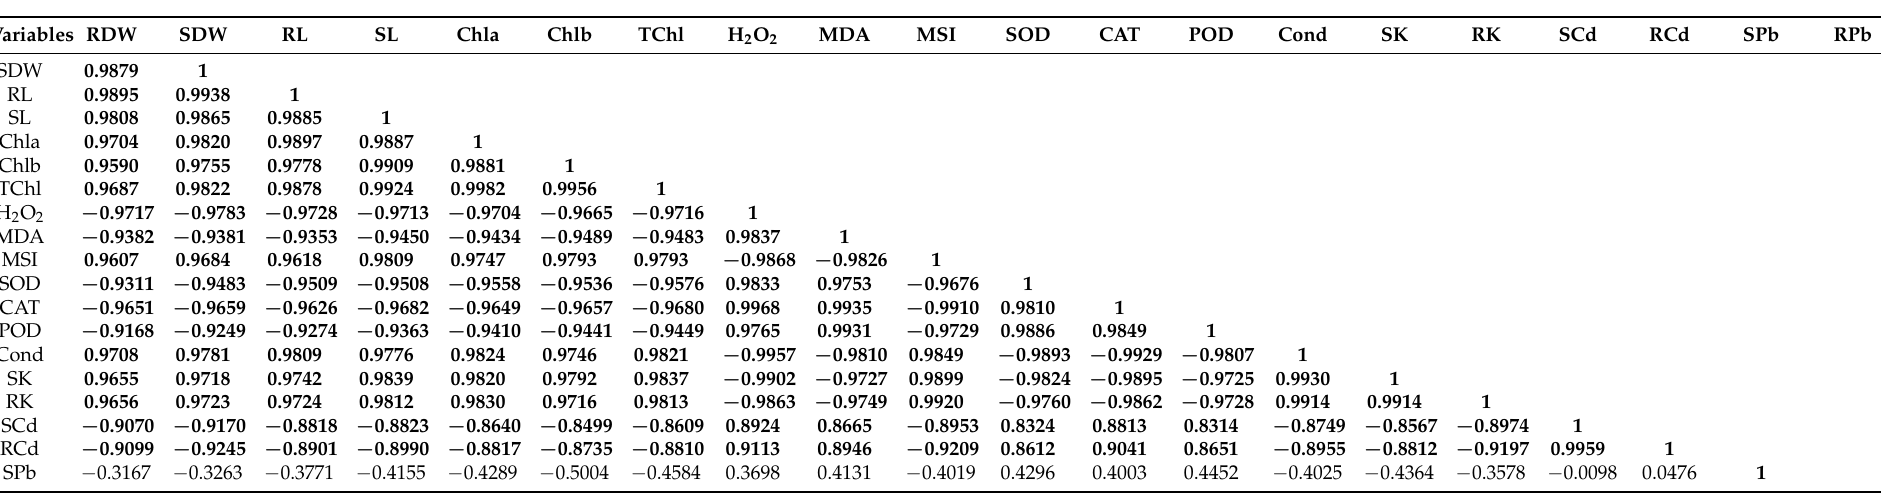
Table 4. Correlation matrix of different variables of quinoa under cadmium and lead stress. Values in bold represent the significant correlations among the